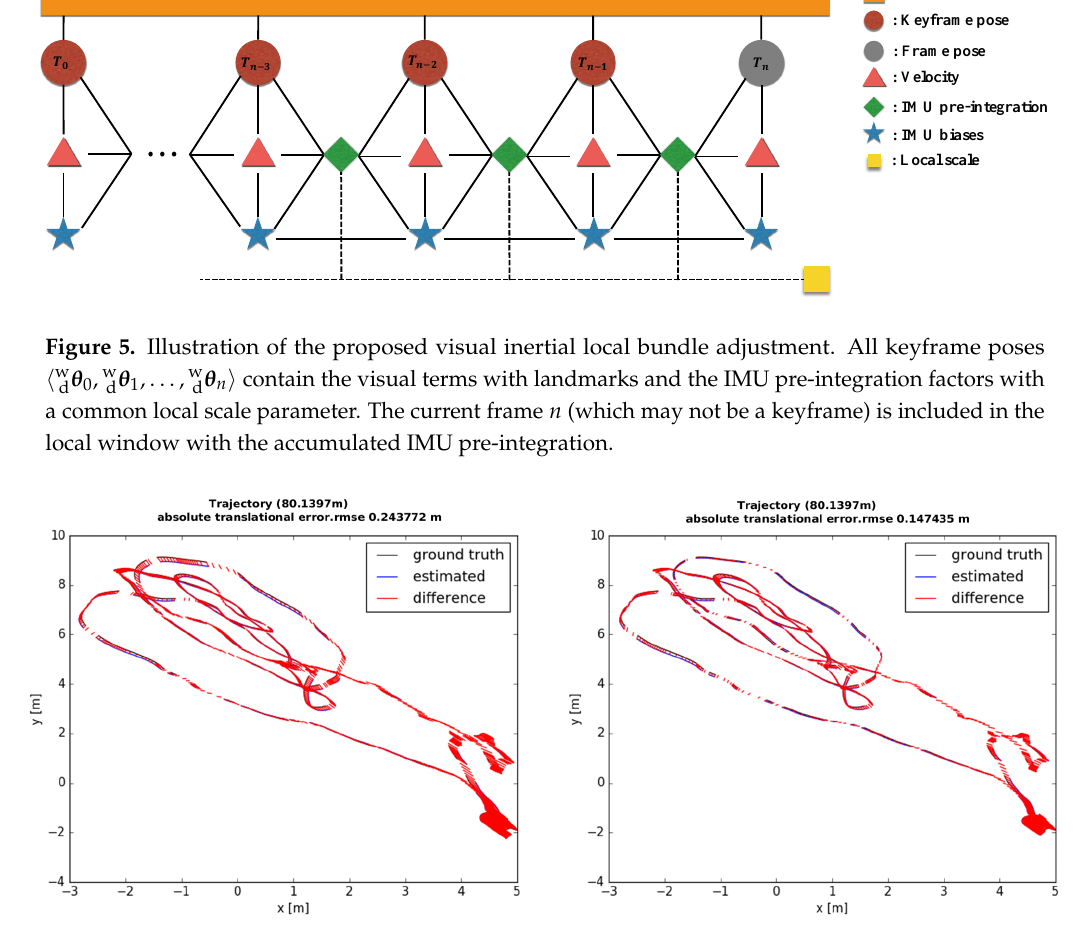
Figure 6. The difference in the trajectories from the ground-truth to the optimization without the scale ( left ) and the proposed optimization with the scale parameter ( right ). The estimated trajectories are aligned to the ground-truth via a rigid transform (special Euclidean group SE3) using the Technical University of Munich (TUM) RGB-D benchmark tool [31]. The proposed method is able to accurately estimate the poses by updating the scale